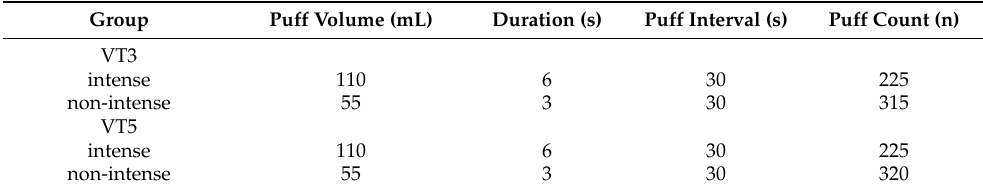
Table 2. Aerosol Generation for